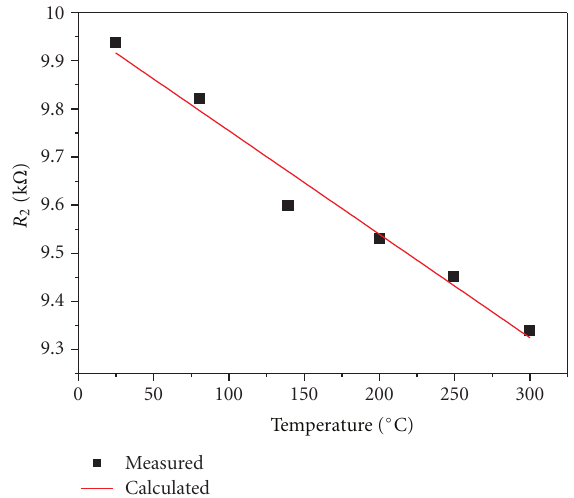
Figure 25: Relation curve between R 2 and the T temperature according to (2).